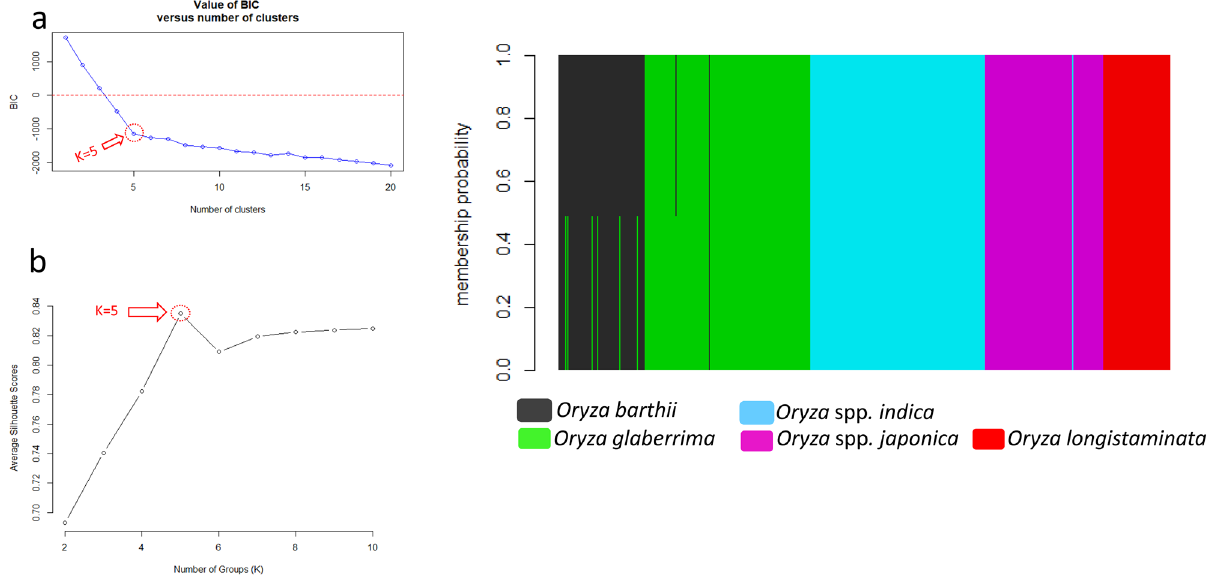
Figure 4. DAPC scatterplots based on the 36 diagnostic KASP markers. ( a ) K number selected based on Bayesian information criterion (BIC) value for cluster up to K = 20; ( b ) Silhouette score by number of groups (K); and ( c ) DAPC plot for the optimal number of clusters, K = 5. Each bar in ( c ) represents an individual (accession) that is coloured according to its probability of belonging to a given